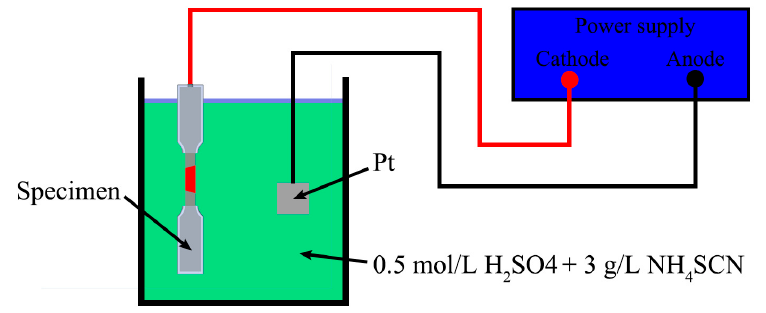
Figure 3. Schematic of the hydrogen charging system.